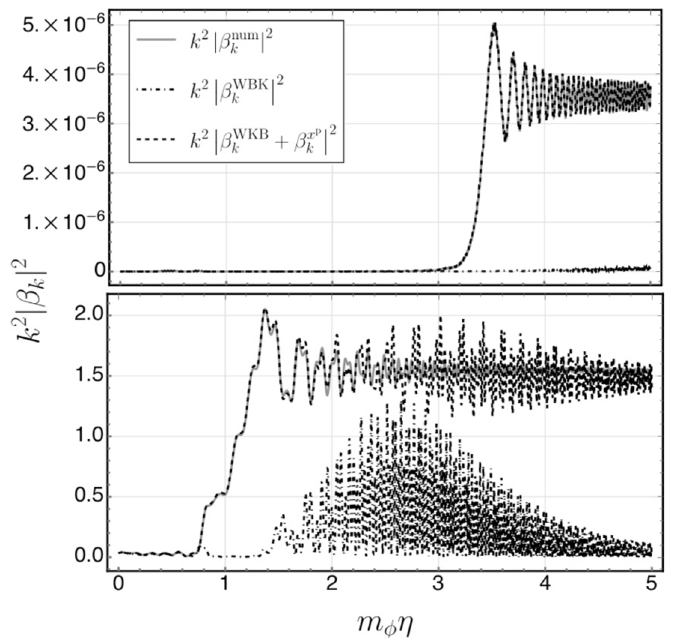
Figure 7 . Particle production as a function of time for di(cid:11)erent kinds of computation: numerical, WKB, and re(cid:12)ned WKB. In this (cid:12)gure, (cid:24) = 1 = 4 and m = 0 : 1 m (cid:30) . The upper panel is calculated for k = 100 m (cid:30) and the lower panel for k = 10 m (cid:30) . The WKB approximation (black dot dashed line at the bottom) does not capture the resonance present in the numerical result (gray continuous line) while the re(cid:12)ned WKB approximation (black dashed line) agrees with the numerical